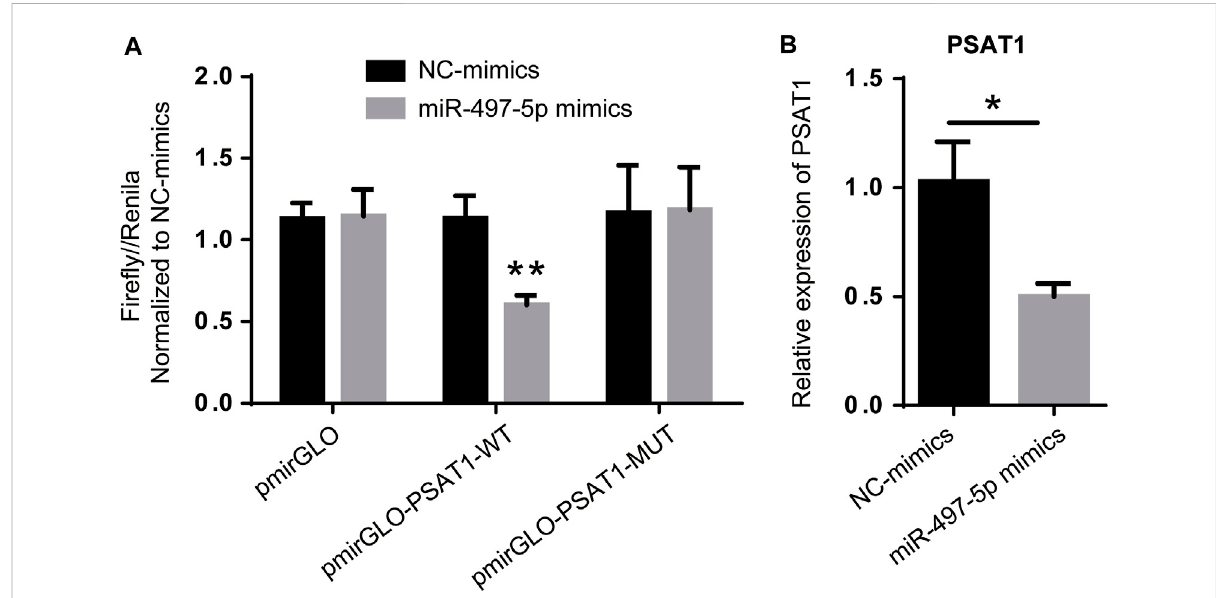
FIGURE 5 PSAT1 expression is regulated by has-miR-497-5p. (A) . PSAT1 and has-miR-497-5p targeting relationship revealed by dual-luciferase reporter gene system. (B) . The expression of PSAT1 was lower in has-miR-497-5p-treated gastric cancer cell lines compared to control cells. * p < 0.05, ** p <